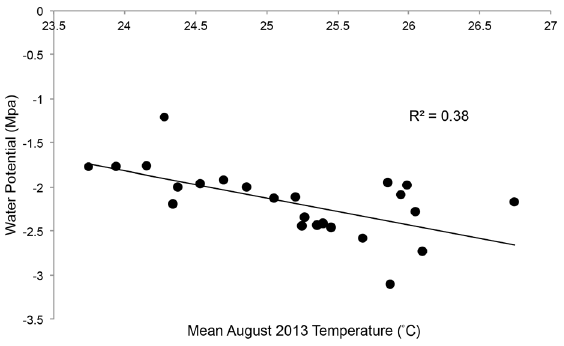
Figure 3. Linear regression of mean August 2013 tree canopy temperature and mean stem water potential (MPa) (y=5.53– 0.31x). Regression model is statistically significant (P , 0.05).